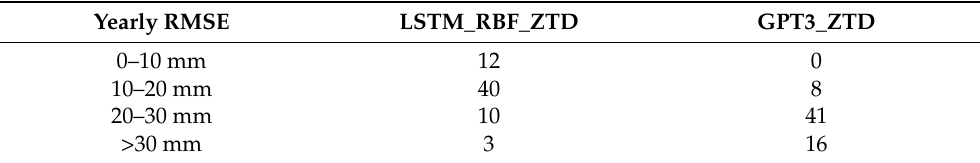
Figure 15. Comparisons between the yearly RMSE of LSTM_RBF_ZTD and GPT3_ZTD in the forecast period at 65 stations. Table 4. Statistical piece-wise yearly RMSE of LSTM_RBF_ZTD and GPT3_ZTD at 65 stations (units: site number).